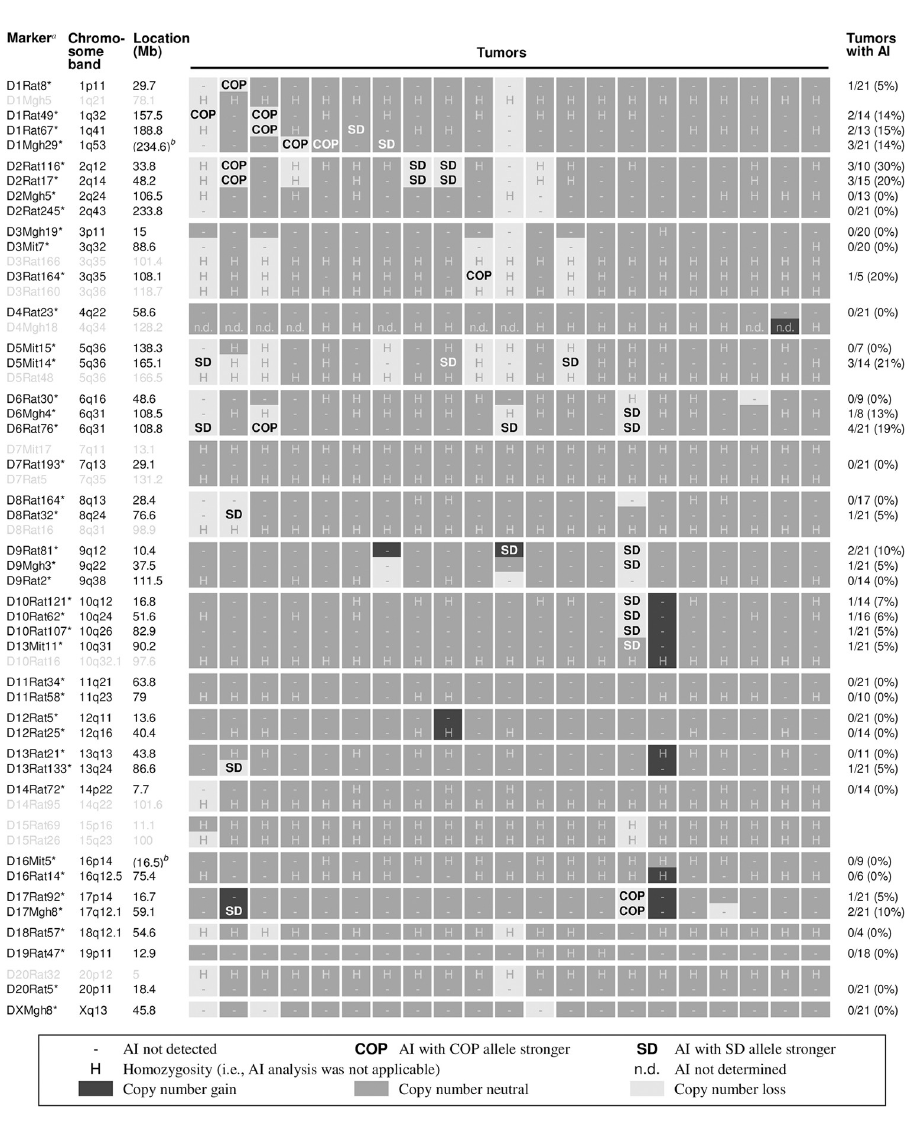
Fig 3. Allelic imbalance (AI) sites observed in (SD × COP)F 1 mammary carcinomas. Results of the AI analysis along with information from microarray-based copy-number analysis (Fig 2), indicated in grey scale. Columns indicate individual tumors. Note that copy-number variations irrelevant to the indicated markers are not shown. a Markers with (black with asterisk) or without (grey) heterozygous individuals. b No data present in the rn4 rat genome assembly; values in parentheses are from the Celera assembly. ‘H’, markers exhibiting homozygosity, where allelic analyses were impossible.